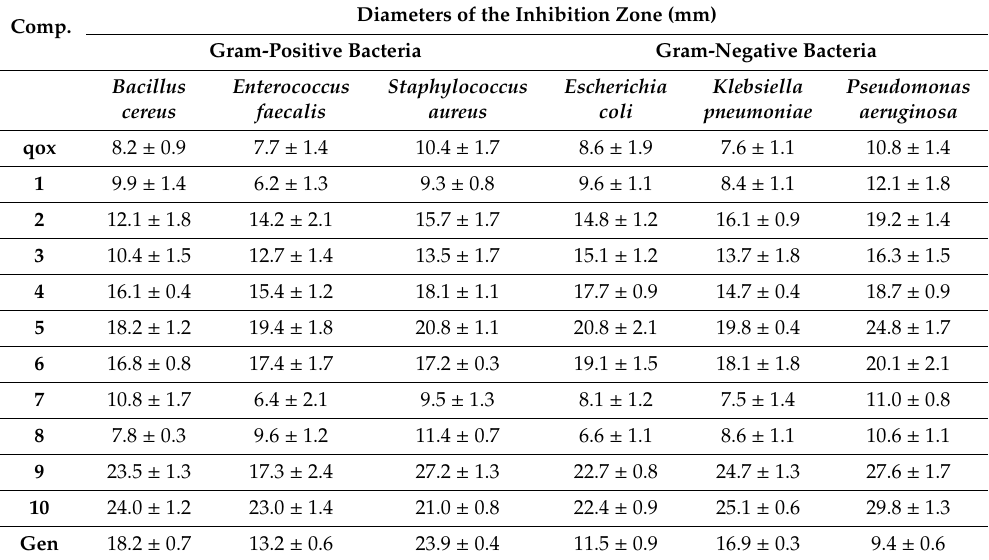
Table 1. Antimicrobial activity of 3-hydroxyiminoquinuclidine ( qox ) and its quaternary salts ( 1 – 10 ) by disc di ff usion assay.